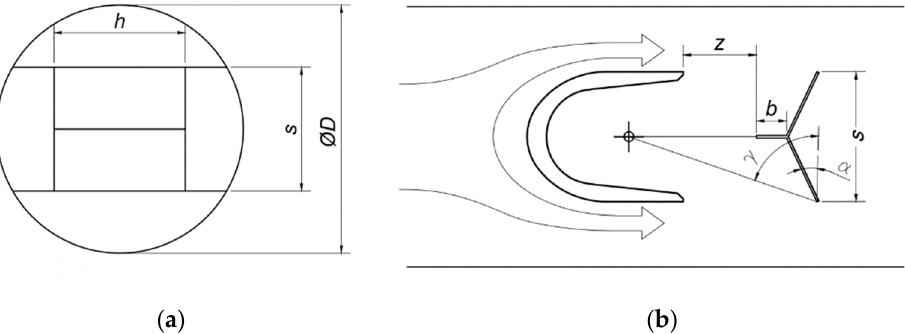
Figure 4. Parameters describing the oscillator’s shape: ( a ) rear view; ( b ) top view. Table 1. Parameters of the studied